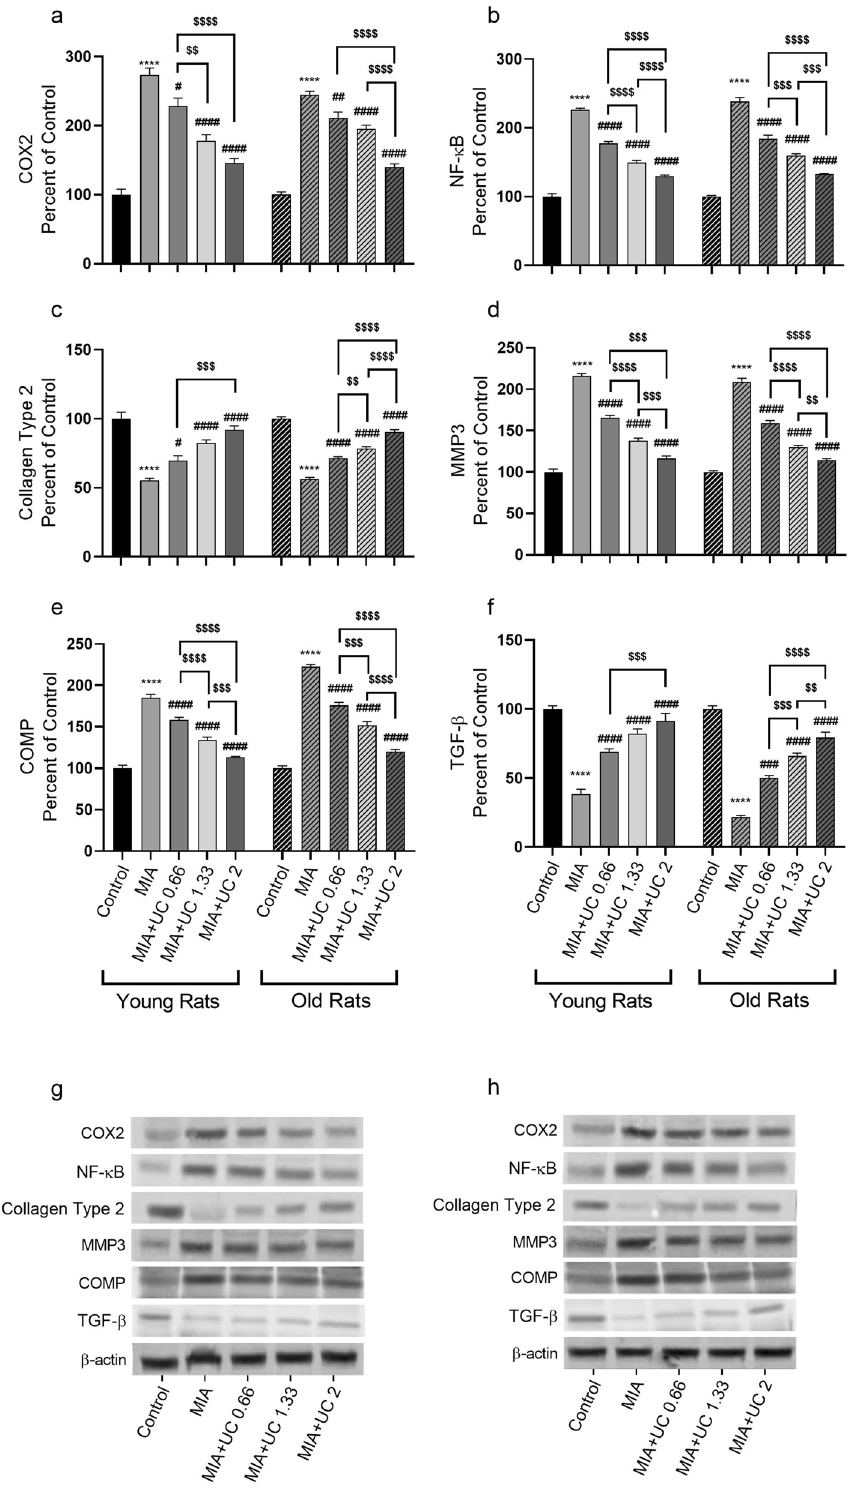
Figure 7. Effects of undenatured collagen (UC) supplementation at different doses on knee joint protein expression of COX2 ( a ), NF-κB ( b ), Collagen Type 2 ( c ), MMP3 ( d ), COMP ( e ), and TGF-β ( f ) levels in monosodium iodoacetate (MIA) induced osteoarthritis in young and old rats. The densitometric analysis of the relative intensity according to the control group of the western blot bands was performed with β-actin normalization to ensure equal protein loading. Blots were repeated at least three times (n = 3), and representative blots were shown ( g for young rats and h for old rats). The bars point out the mean ± standard error of the mean (SEM). ANOVA and Tukey’s post hoc test were used to compare the results among different treatment groups. Statistical analysis was performed separately within each age group. Statistical significance between groups is shown by: **** p < 0.0001 (MIA vs. Control), # p < 0.05; ## p < 0.01; ### p < 0.001; #### p < 0.0001 (MIA vs. UC groups), and $$ p < 0.01; $$$ p < 0.001; $$$$ p < 0.0001(pairwise comparisons between UC